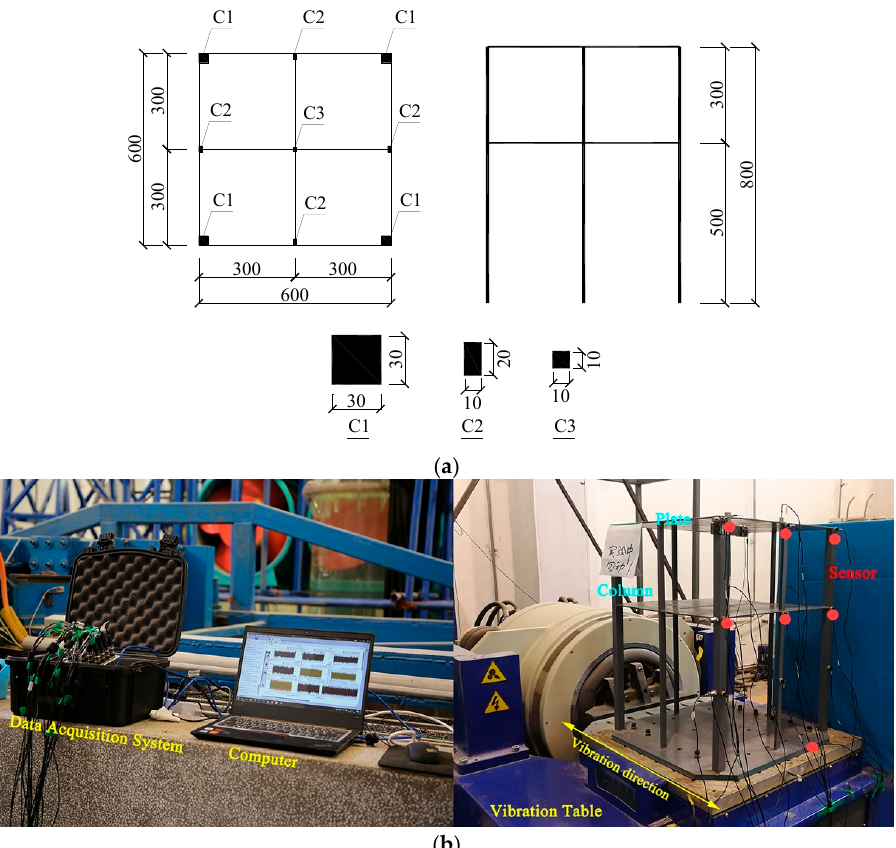
Figure 3. Test model information: ( a ) structural design and ( b ) experiment model.